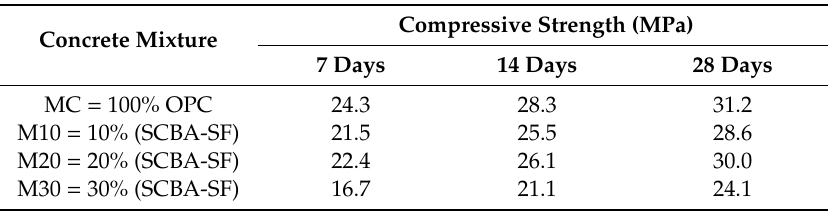
Table 4. Compressive strength at 7, 14, and 28 days (F’c in MPa).